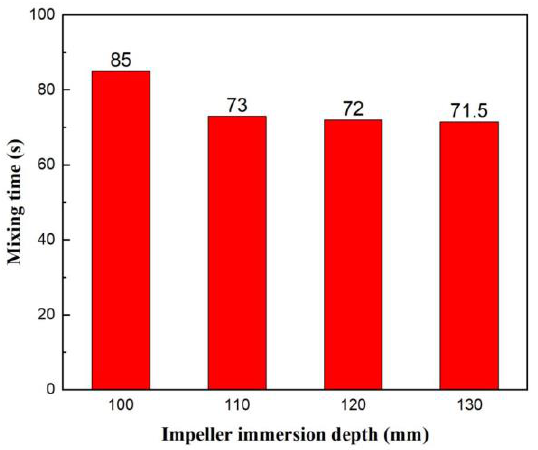
Figure 15. Comparison of mixing times at different IIDs.